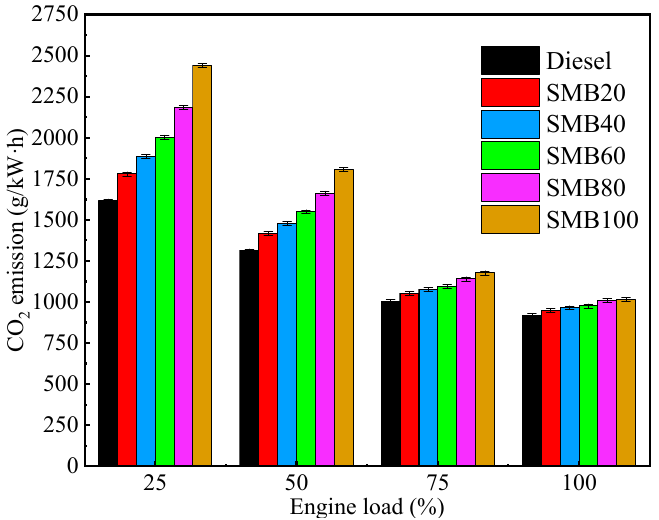
Figure 24. CO 2 emission comparison of SME biodiesel and diesel under different loads [231].